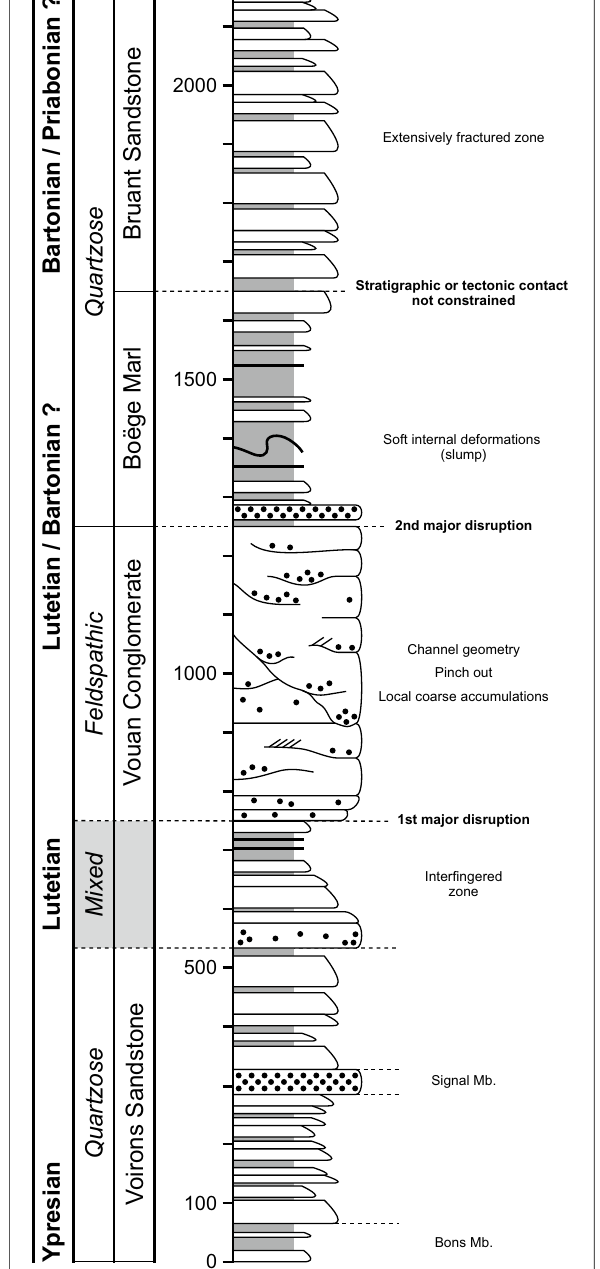
Fig. 4 Synthetic stratigraphic log of the Voirons Flysch based on the most extensive section in the Voirons. The Allinges Mb. and the Fenalet Sandstone are not included in this figure because they are not exposed in this